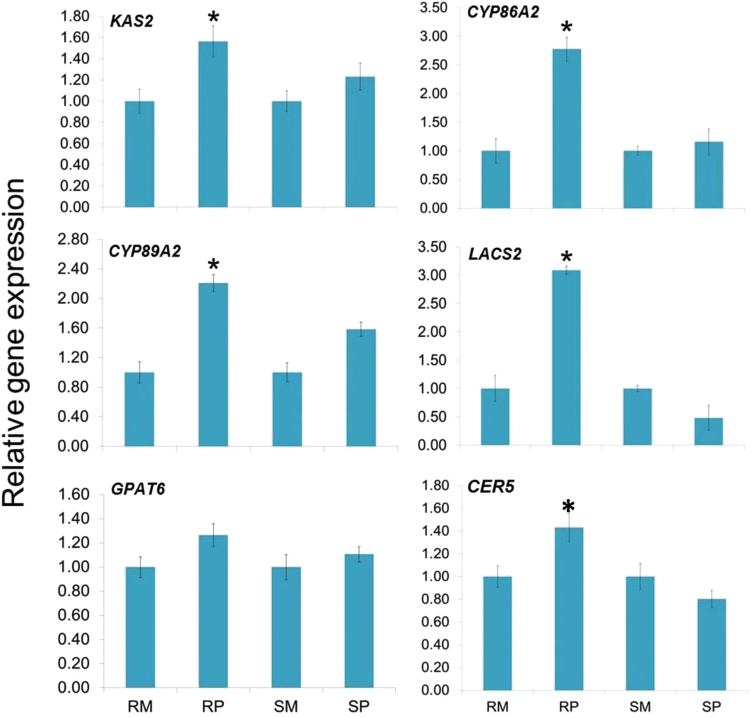
Relative transcript expression of RR genes from spikelet samples of resistant and susceptible genotypes following F. graminearum and mock inoculation at 72 hpi based on qPCR in comparison to reference gene Actin. CI9831 and H106-371 are resistant and susceptible genotypes, respectively. Error bars represent ±SE. Significant differences in relative expression levels using Student’s t-test: *, P<0.05. A colour version of this figure is available at JXB online.